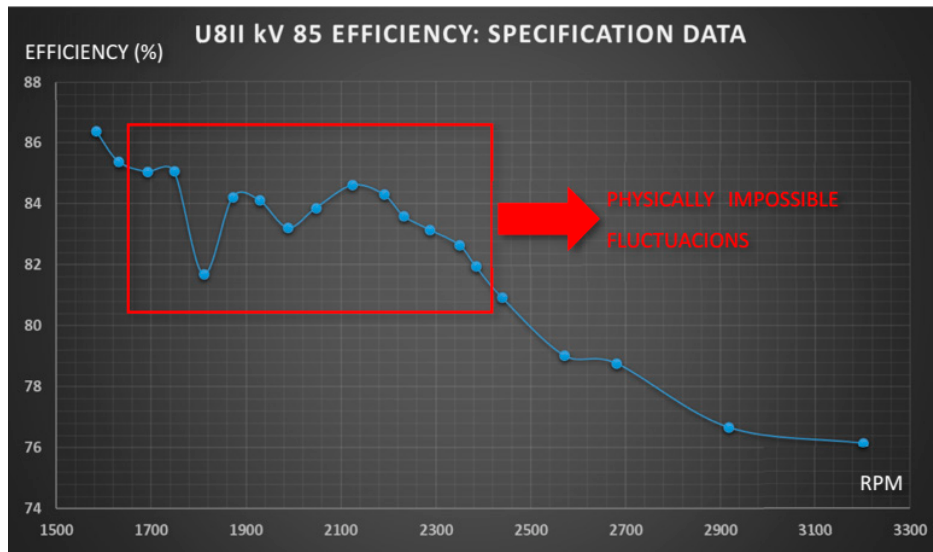
Figure 2. Inaccuracy in the U8II kV 85 specifications.